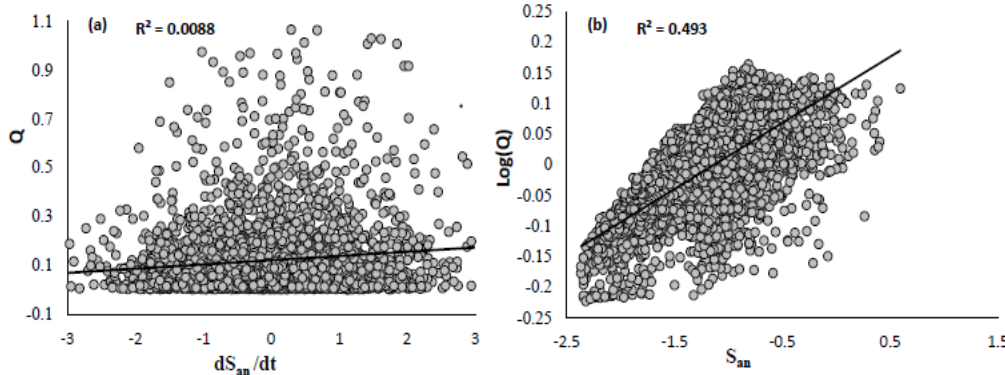
Figure 2. ( a ) There is almost zero correlation between dS an / dt and Q due to high observational errors associated with dS an / dt, suggesting that dS an / dt cannot be used to predict Q. Although Q vs. S an plot exhibits less scatter, the correlation is not very strong, likely because of the fact that the relationship is not one-to-one as shown in ( b ). Note that the figure was prepared using data from the sample basin of Bluestone river near Pipestem, West Virginia with USGS id 03179000 having drainage area of 395 square miles.